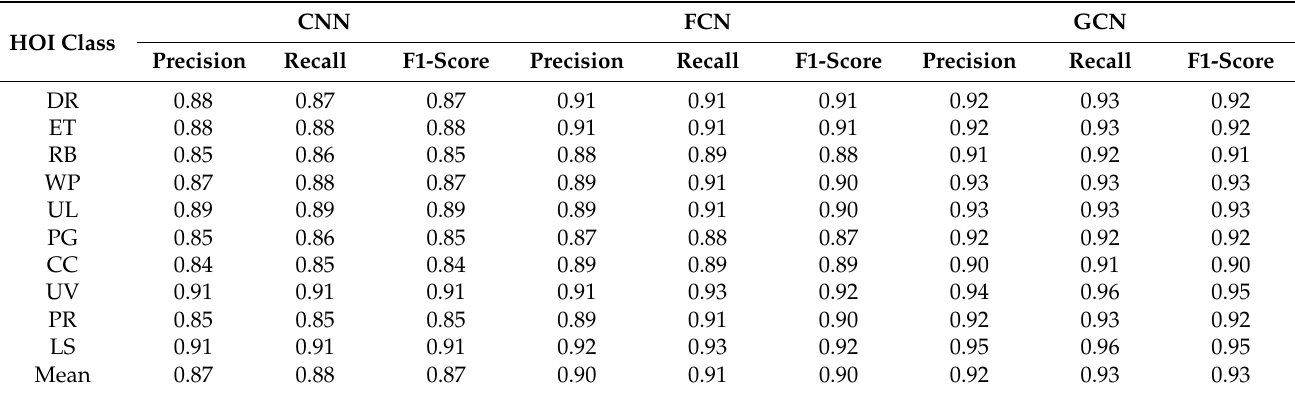
Table 7. Comparison of GCN with CNN and FCN classifiers on MSR Daily Activity dataset in terms of precision, recall and F1-score.